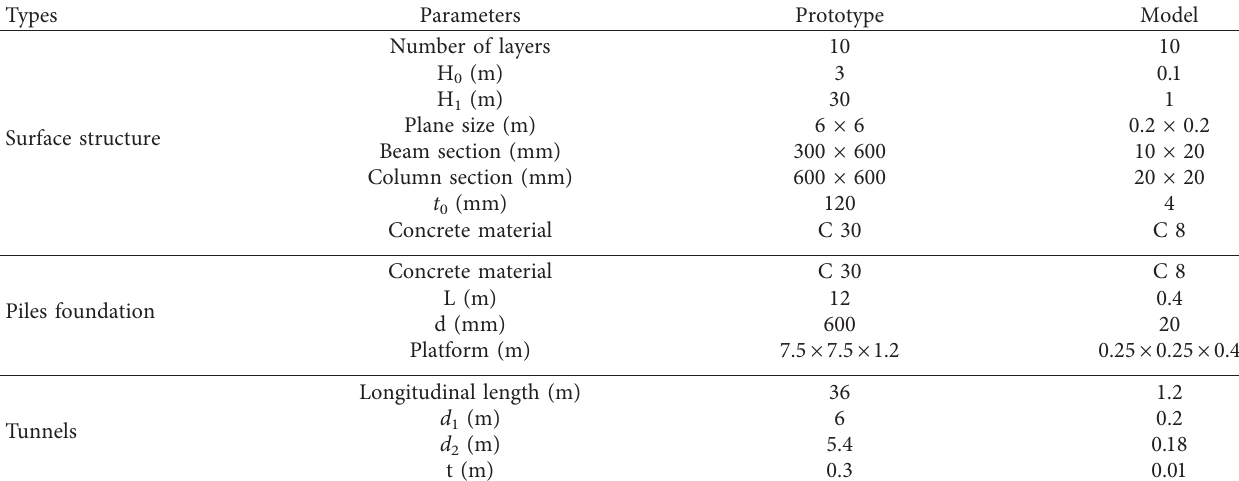
Table 3: Dimensions of the prototype and